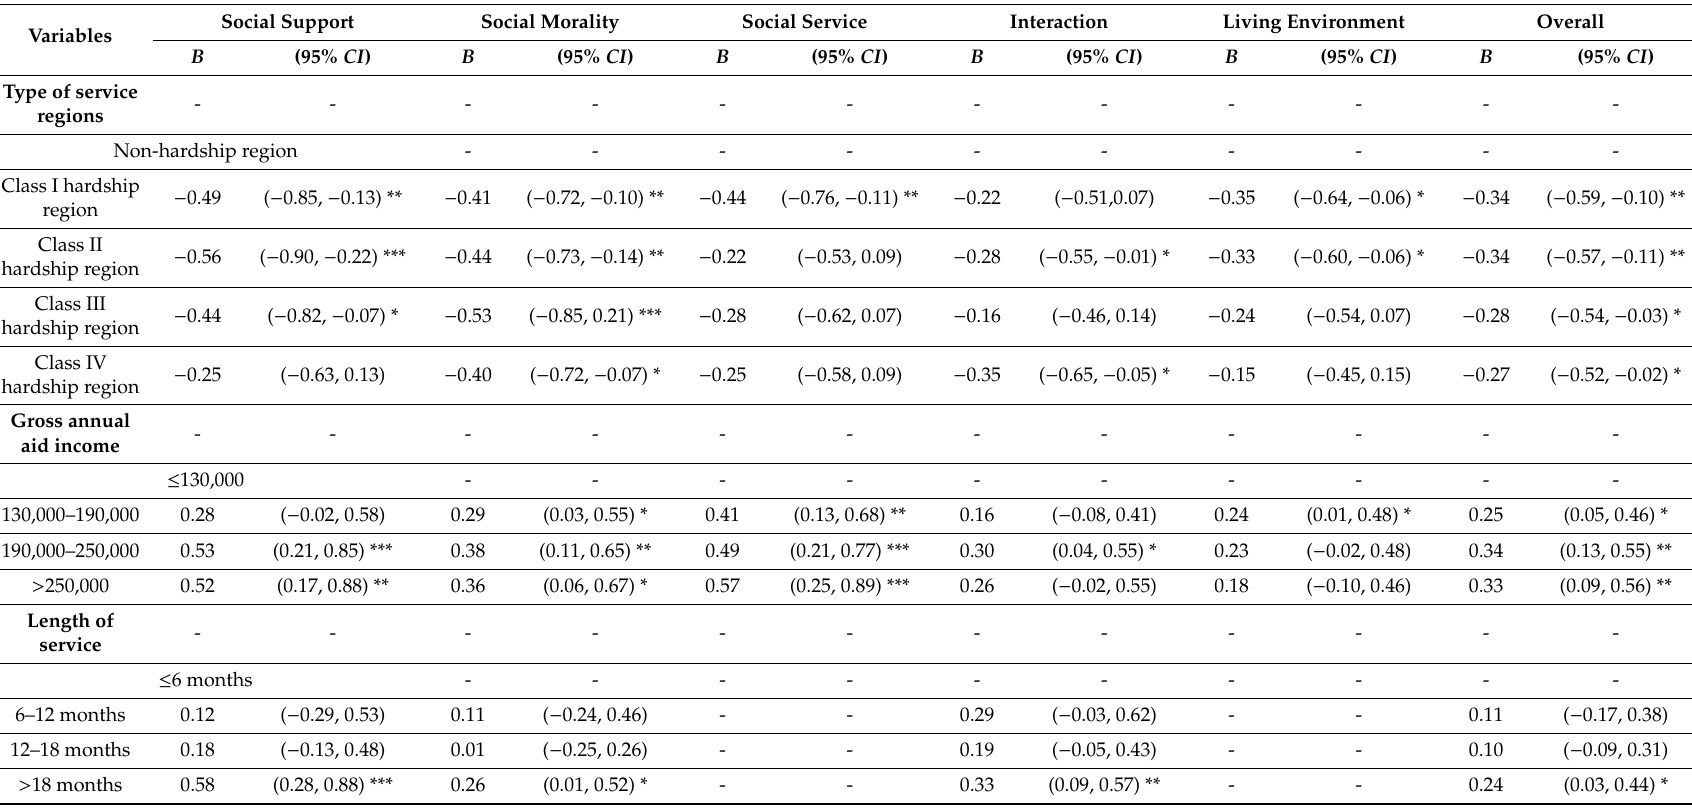
Table 4. Linear regression models of related factors for overall socio-cultural adaptation and adaptation of each